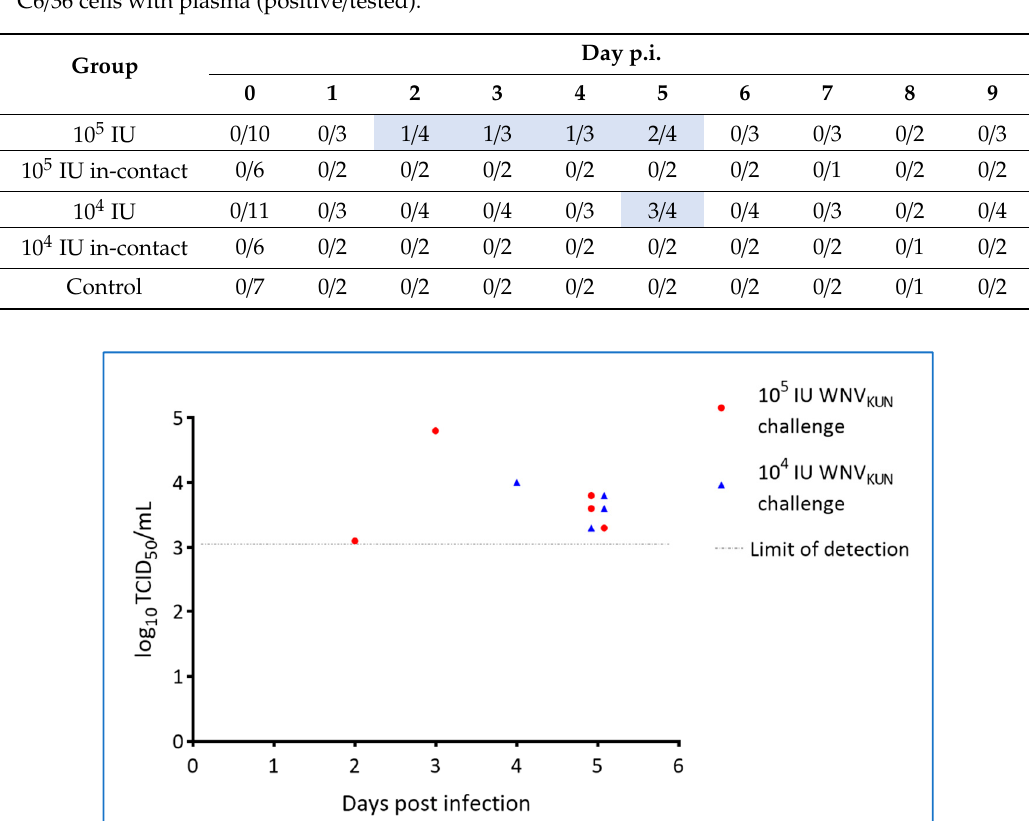
Figure 6. Viral titres in plasma from hatchling saltwater crocodiles following experimental WNV KUN challenge. Stippled line indicates limit of detection.